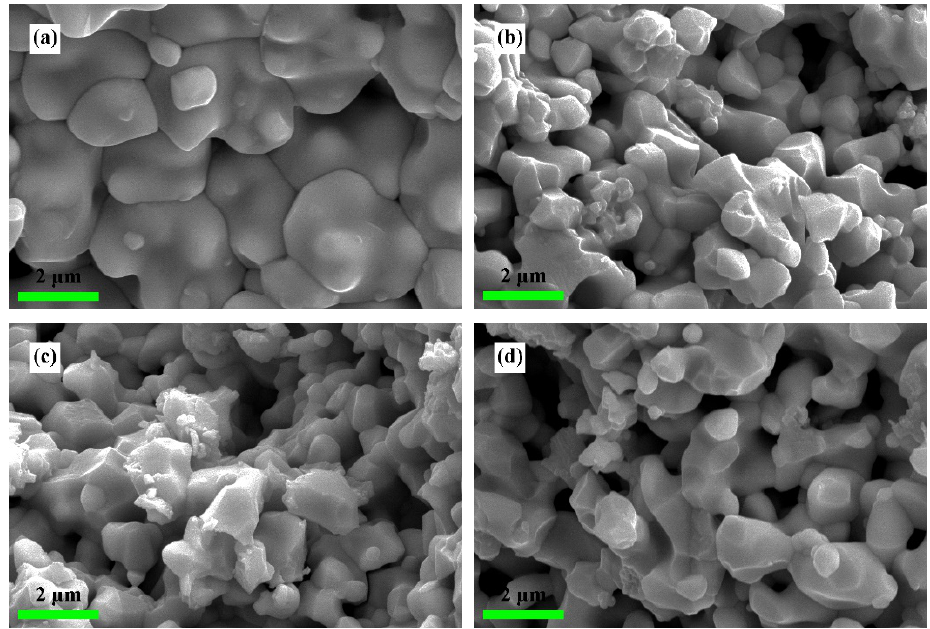
Fig. 2 SEM micrographs of as-prepared ceramics: (a) BFO, (b) BSFO, (c) BGFO, and (d)